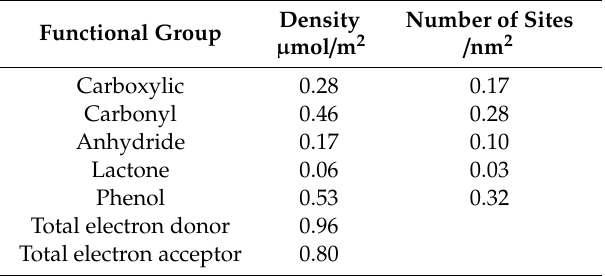
Table 2. Functional groups on activated carbon Norit SA Super by Boehm